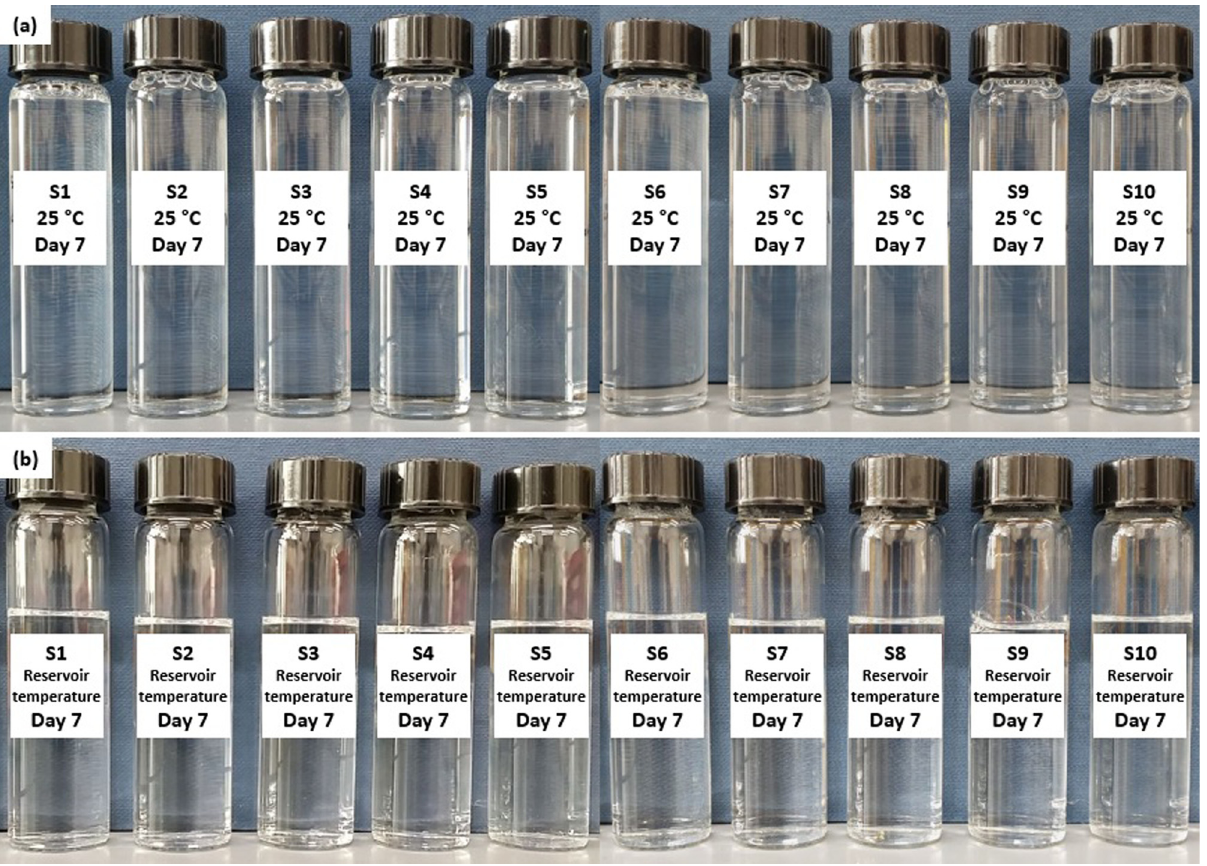
Figure 5: Solubility and compatibility of 1.0 wt% surfactant concentration at ( a ) 25°C and ( b ) reservoir